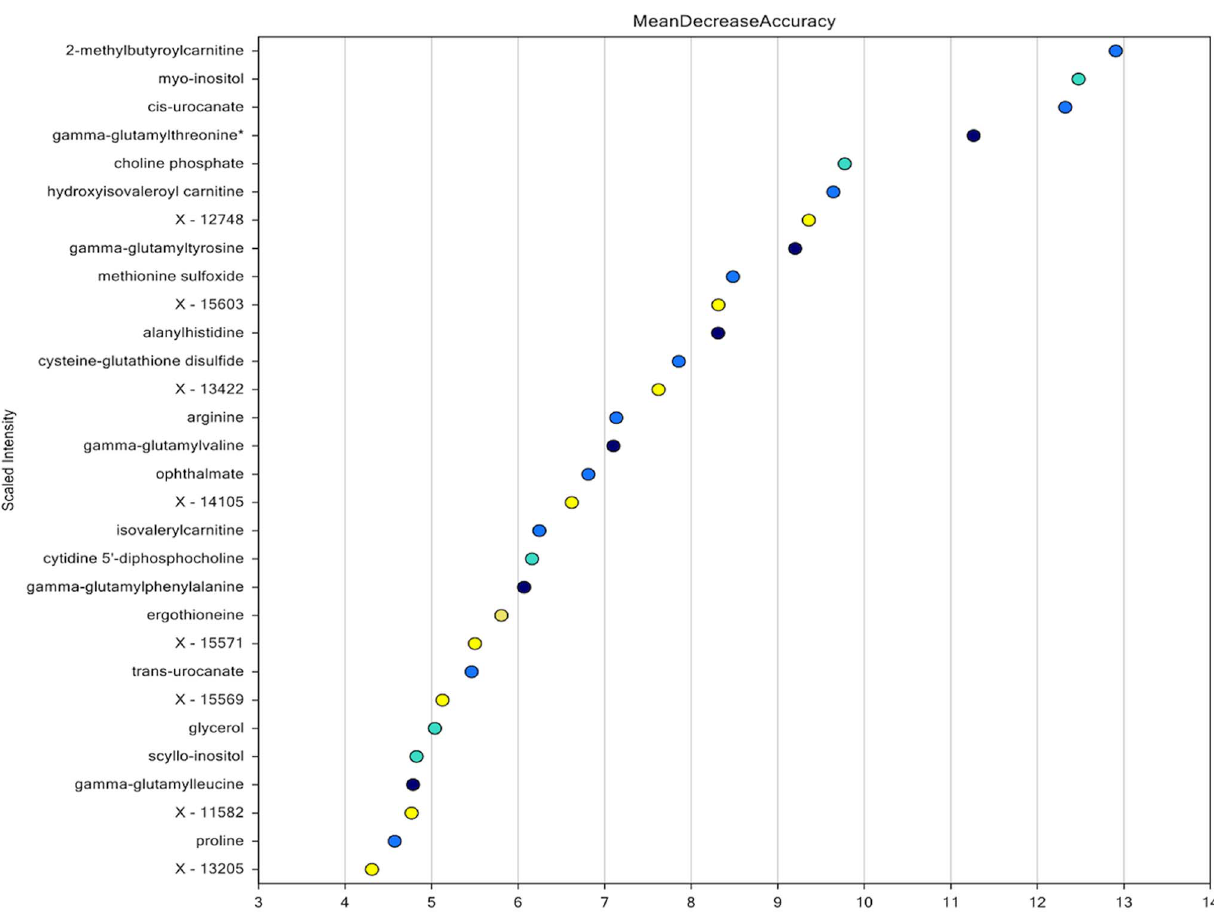
Figure 3. Random forest classification. Random forest classification presenting the prioritized list of 30 metabolites. Metabolites with X- prefix are unknown and need to be identified. Y-axis is the prioritized list in which we as move downward, there is decrease in the accuracy (X-axis) of classification of the two samples.